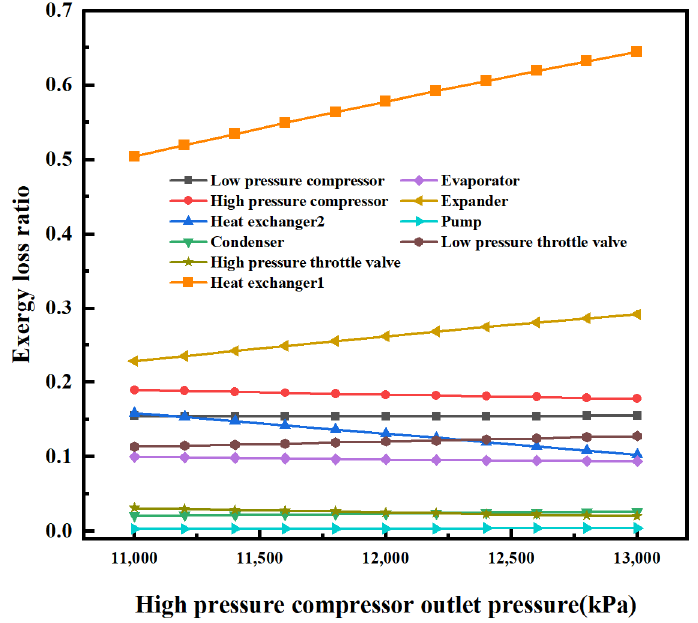
Figure 9. Exergy loss rate of each component of the coupling system varied with the outlet pressure of the high-pressure compressor.